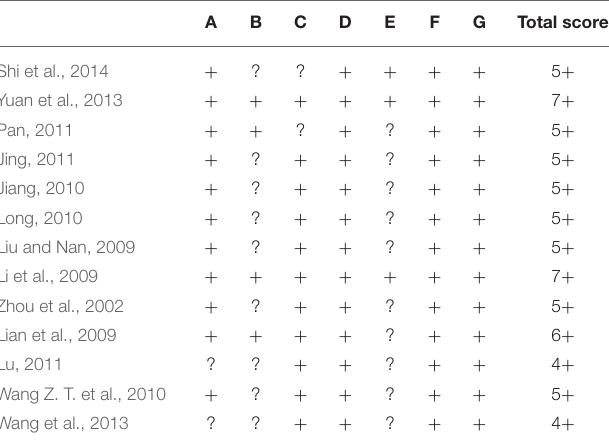
TABLE 5 | The methodological quality of included studies.